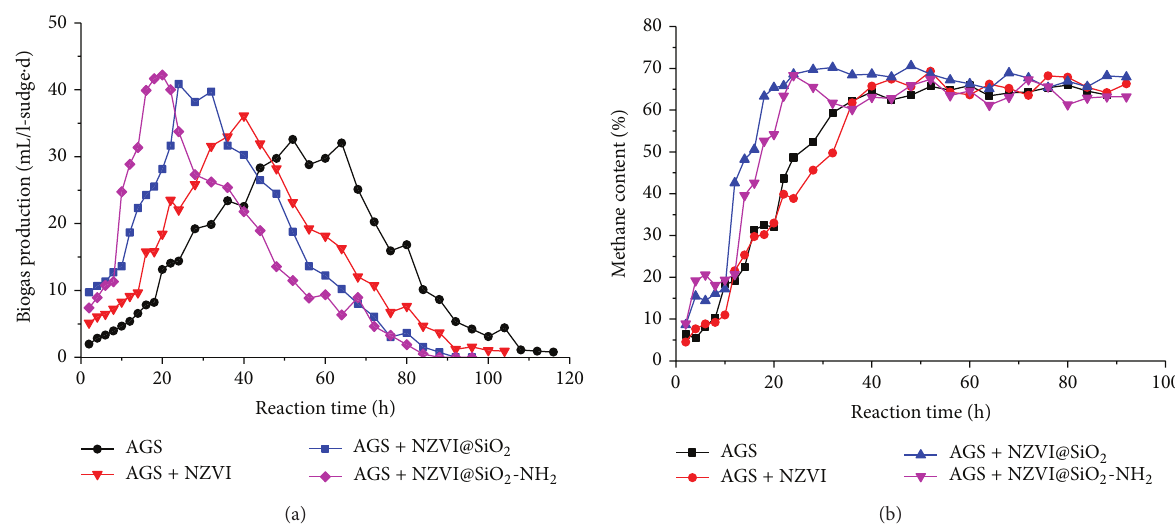
Figure 7: Effect of NZVI@SiO 2 -NH 2 on the yield (a) and concentration (b) of methane production in anaerobic granule sludge system.